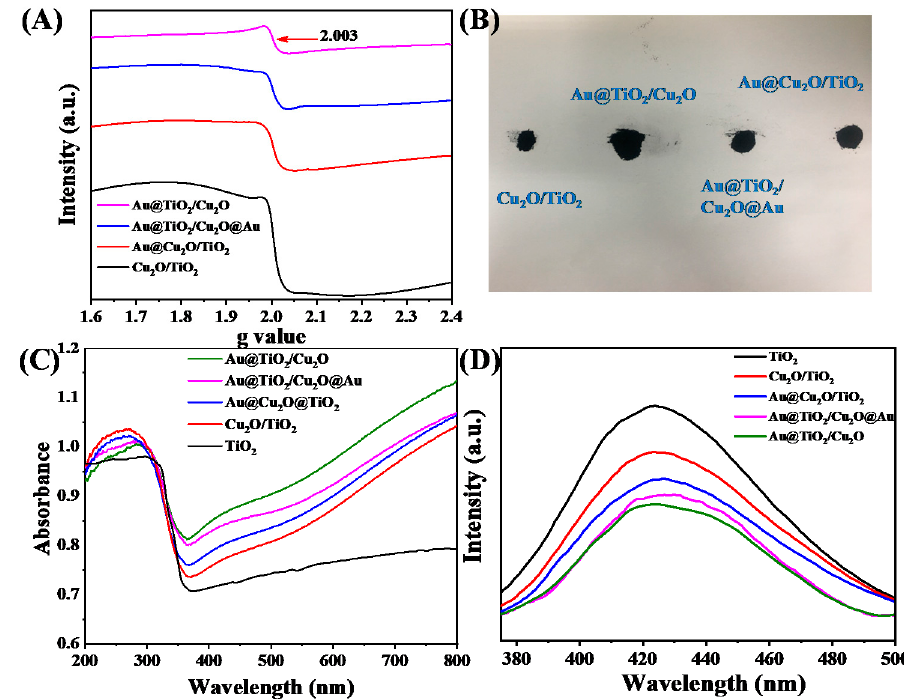
Figure 4. The EPR spectra ( A ) and digital photos ( B ) of Cu 2 O / TiO 2 , Au@Cu 2 O / TiO 2 , Au@TiO 2 / Cu 2 O@Au, and Au@TiO 2 / Cu 2 O; UV-Vis absorption spectra ( C ) and Fluorescence emission spectra ( D ) of TiO 2 , Cu 2 O / TiO 2 , Au@Cu 2 O / TiO 2 , Au@TiO 2 / Cu 2 O@Au, and Au@TiO 2 / Cu 2 O. The excitation wavelength is 350 nm.